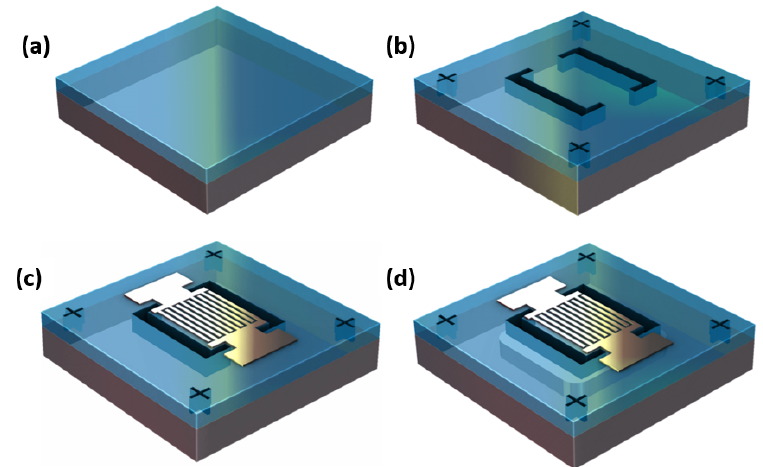
Figure 4. Fabrication steps of CLMR. ( a ) deposition of piezoelectric layer. ( b ) Reactive ion etching (RIE) of AlN/AlScN trenches and alignment marks. ( c ) Lift-off of 40 nm Al patterned using Electron Beam Lithography (EBL) tool. ( d ) dry release in XeF 2 .